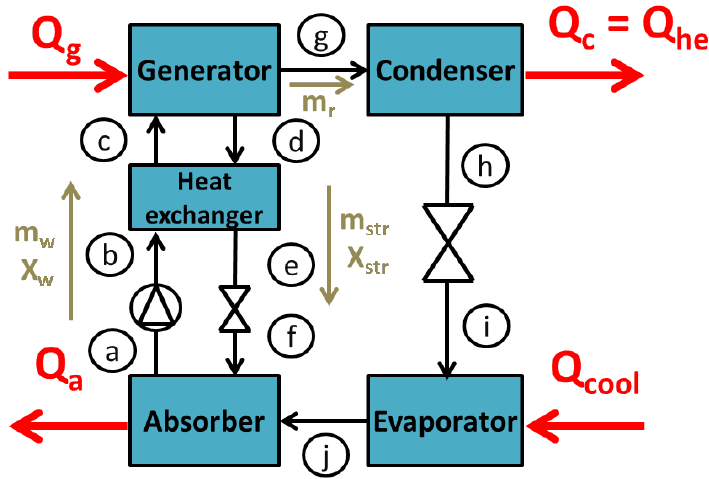
Figure B1. The basic depiction of the absorption chiller operating with the LiBr – H 2 O working pair. Figure A2. The basic depiction of the absorption chiller operating with the LiBr–H 2 O working